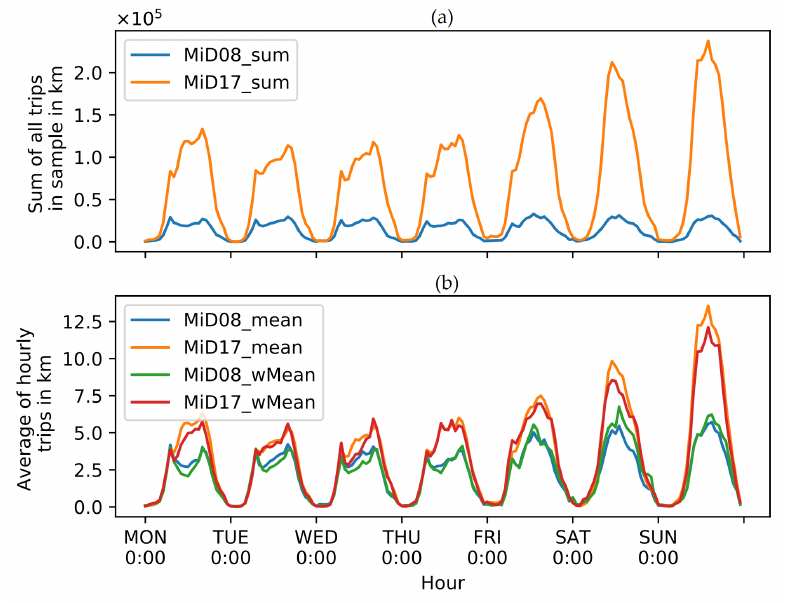
Figure 2. Results of the mobility pattern analysis for a representative week based on the sample populations of MiD08 and MiD2017. Figure ( a ) shows the absolute sample population while the bottom shows the average hourly trip distance. The mean for Figure ( b ) is calculated by the simple arithmetic mean (‘_mean’) and taking into account MiD trip weights